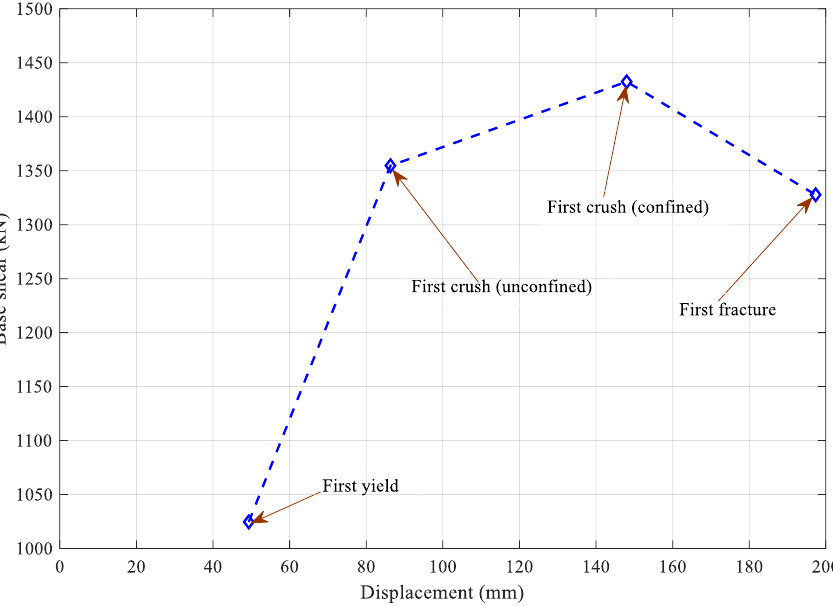
Figure 10. Damage pattern for bare frame analysis scenario.